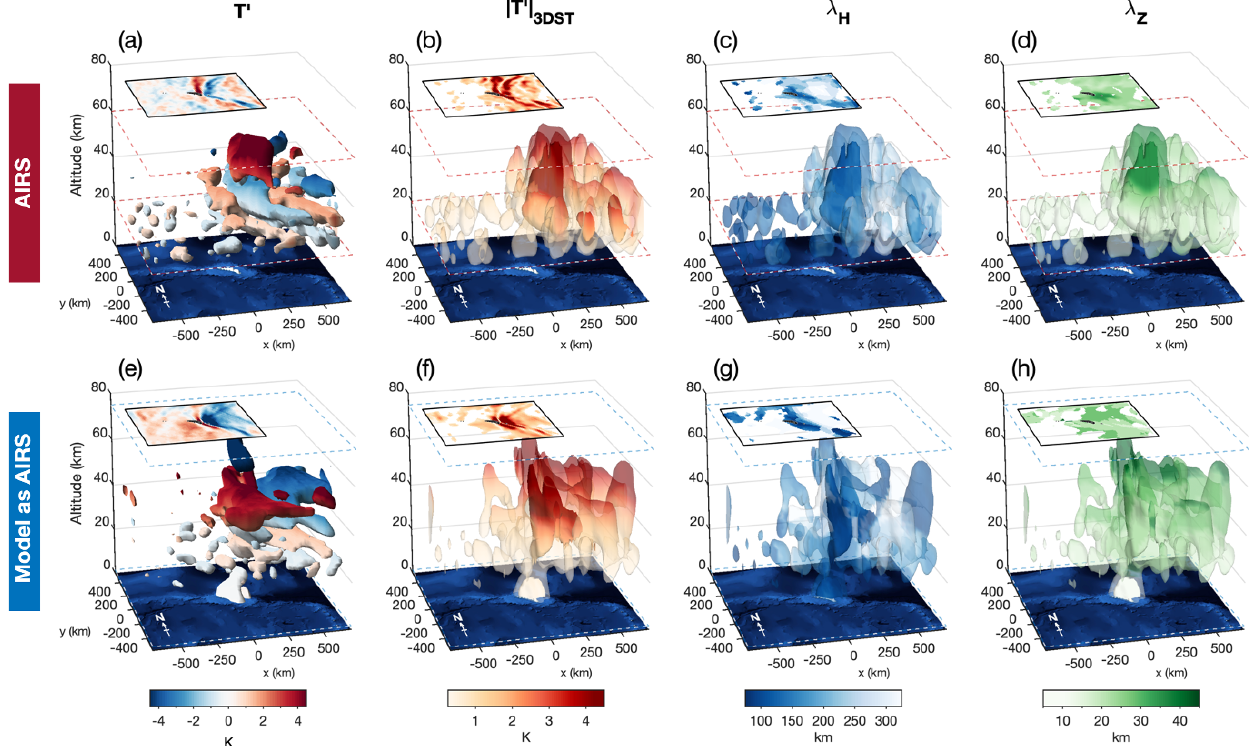
Figure 6. The 3-D S -transform (3DST) analysis of temperature perturbations from AIRS satellite observations (a–d) and the model sampled as AIRS (e–h) over South Georgia for 17:00UTC on 5 July 2015. Coloured isosurfaces in (a, e) show the AIRS and model-sampled-as-AIRS temperature perturbations T (cid:48) , while (b, f) , (c, g) , and (d, h) show 3DST-measured absolute wave amplitude | T (cid:48) | 3DST , horizontal wavelength λ H , and vertical wavelength λ z respectively. Dashed blue and dashed red lines denote the upper and lower boundaries of the model domain and the AIRS measurements respectively. Horizontal cuts through the data at 40km altitude are shown in the top left corners of each panel, which share a colour scale with the isosurfaces.